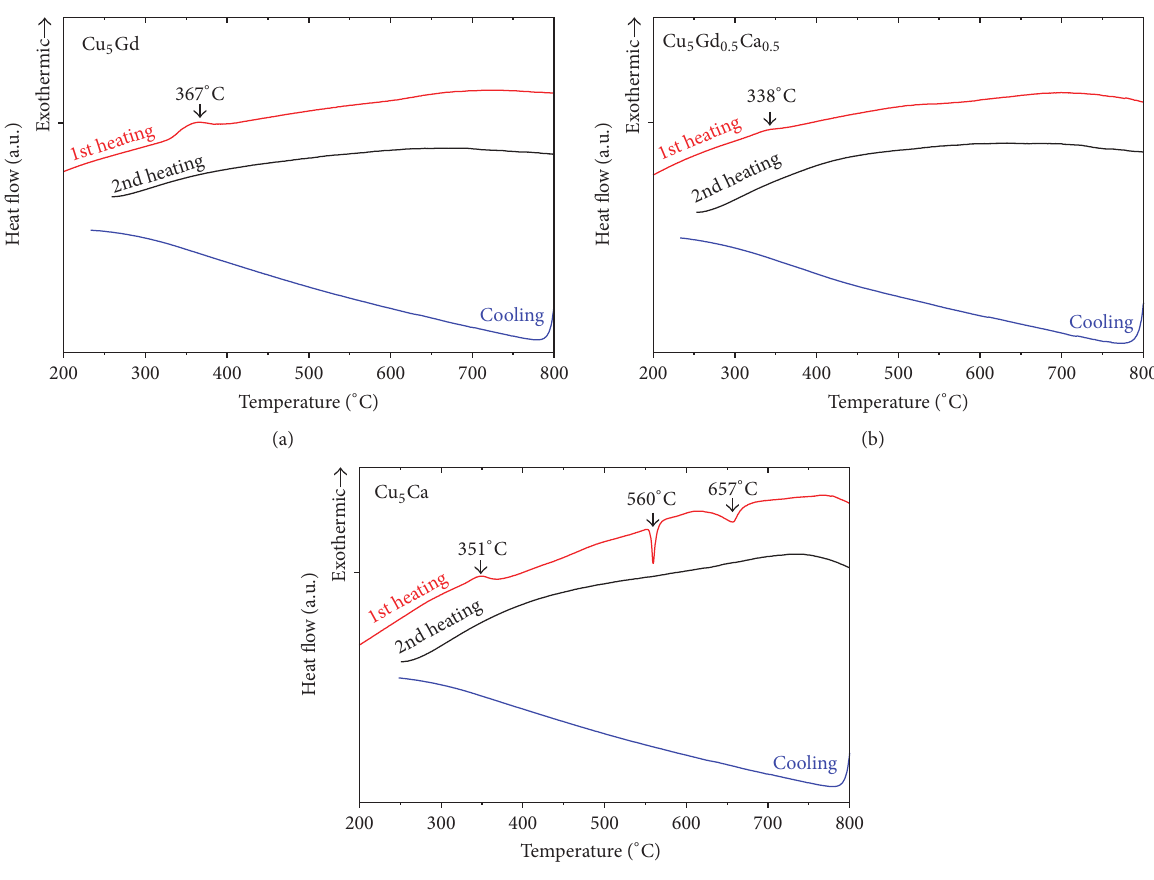
Figure 6: DSC analysis of Cu 5 Gd 1−𝑥 Ca 𝑥 ( 𝑥 = 0, 0.5, and 1) melt-spun ribbons during two-stage heating